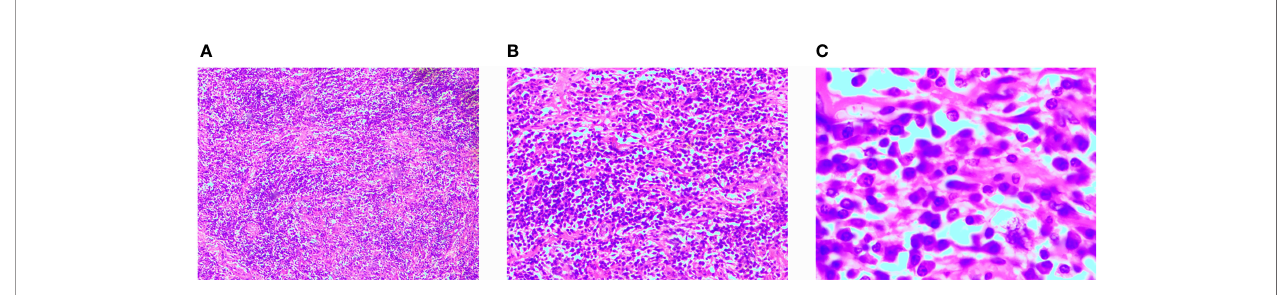
FIGURE 3 | Histological fi ndings. Hematoxylin and Eosin staining of paraf fi n-embedded sections. (A) Magni fi cation × 40. (B) Magni fi cation × 100. (C) Magni fi cation